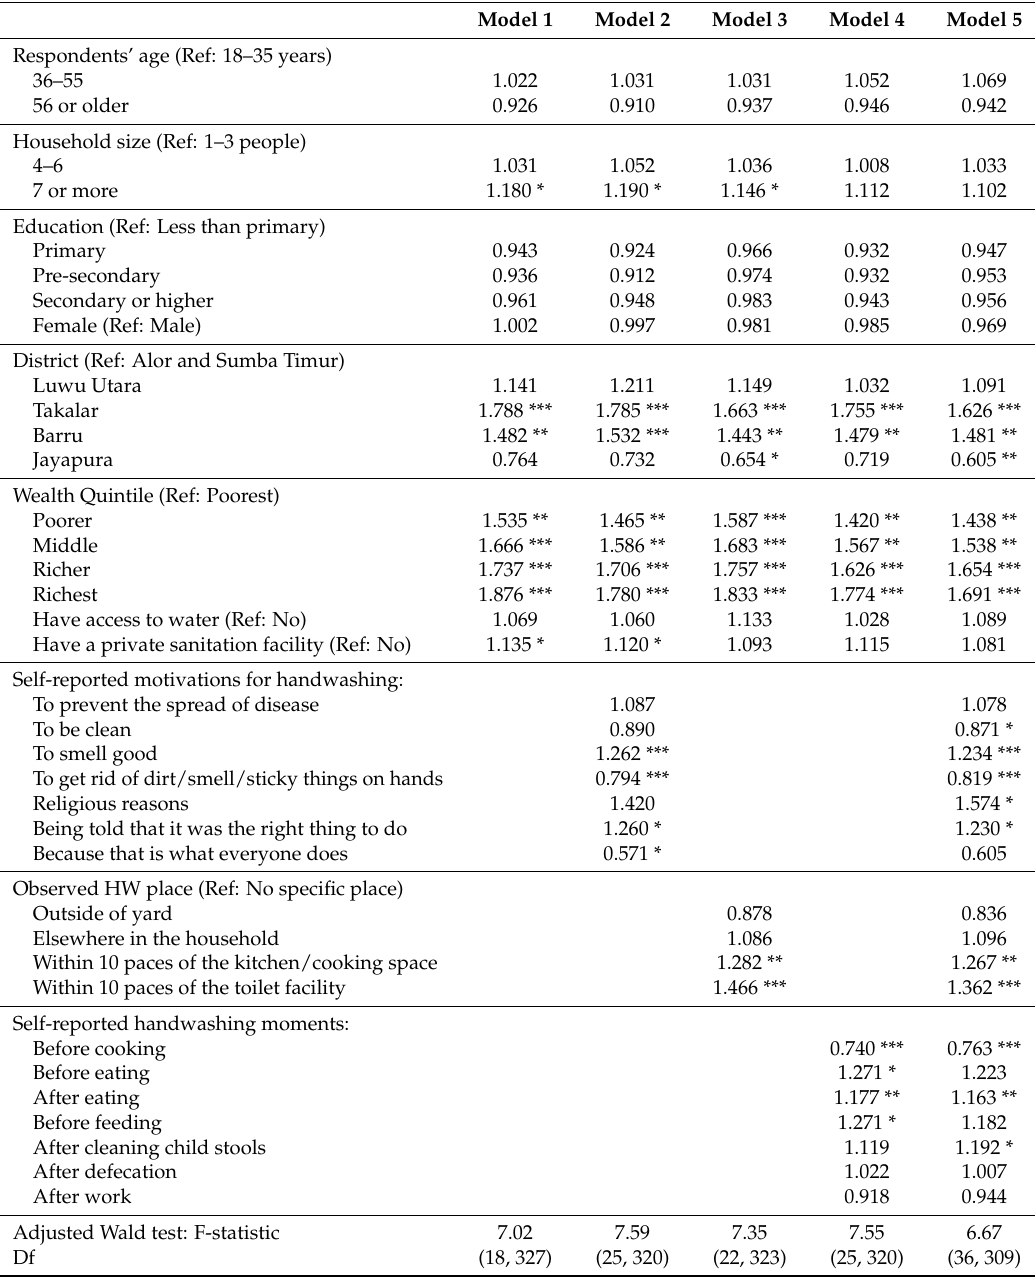
Table 4. Multivariate GLM regression (Family: Poisson, Link: Log) of handwashing with soap presented in prevalence ratio. Indonesia, 2014, n =